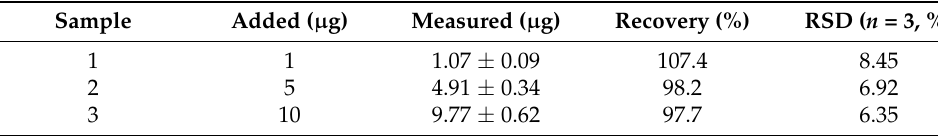
Table 1. Recoveries of SrMV CP from spiked